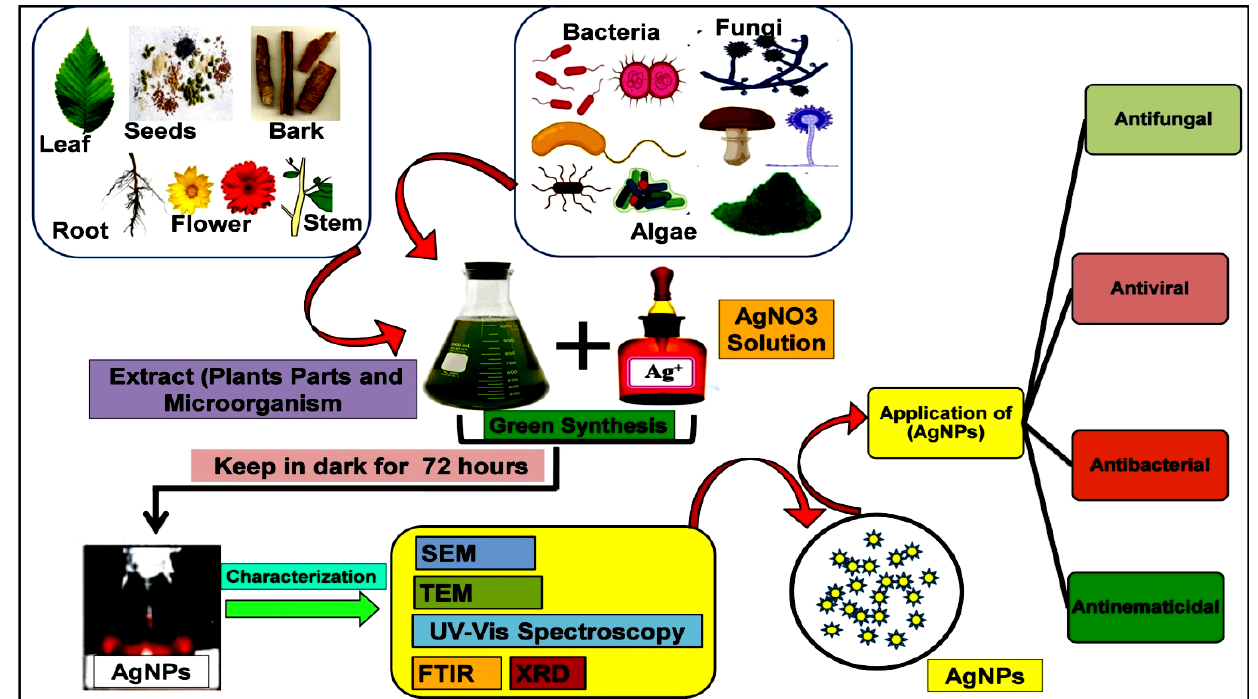
Figure 2. Illustration of green synthesis of AgNPs from various extracts such as plant parts (i.e., stem, leaf, flower, barks, seeds, and root) and microorganisms. Prepared extracts of known dilutions are mixed with predefined molarity of silver nitrate (AgNO 3 ) solution and stirred/kept under dark conditions for a fixed time, e.g., 72 h. Following harvest, the AgNPs are physicochemically characterized for size, shape, and surface area, charged by techniques such as transmission electron microscopy (TEM), scanning electron microscopy (SEM), UV-Vis spectroscopy, FTIR, XRD, DLS, and zeta-potential, etc., and applied for several purposes such as removal of bacteria, fungi, viruses, or